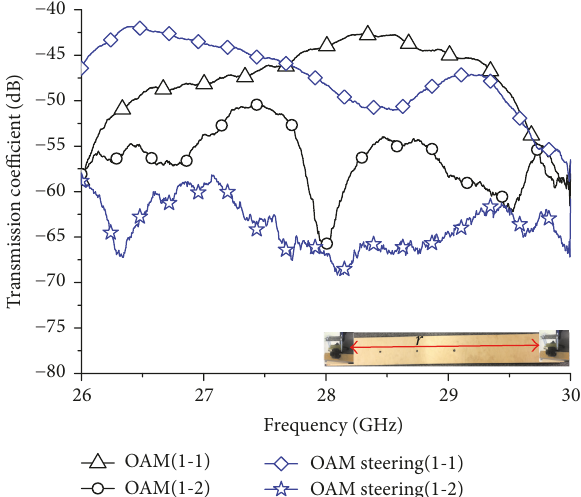
Figure 16: Transmission coefficientsusing nonsteering and steering OAM